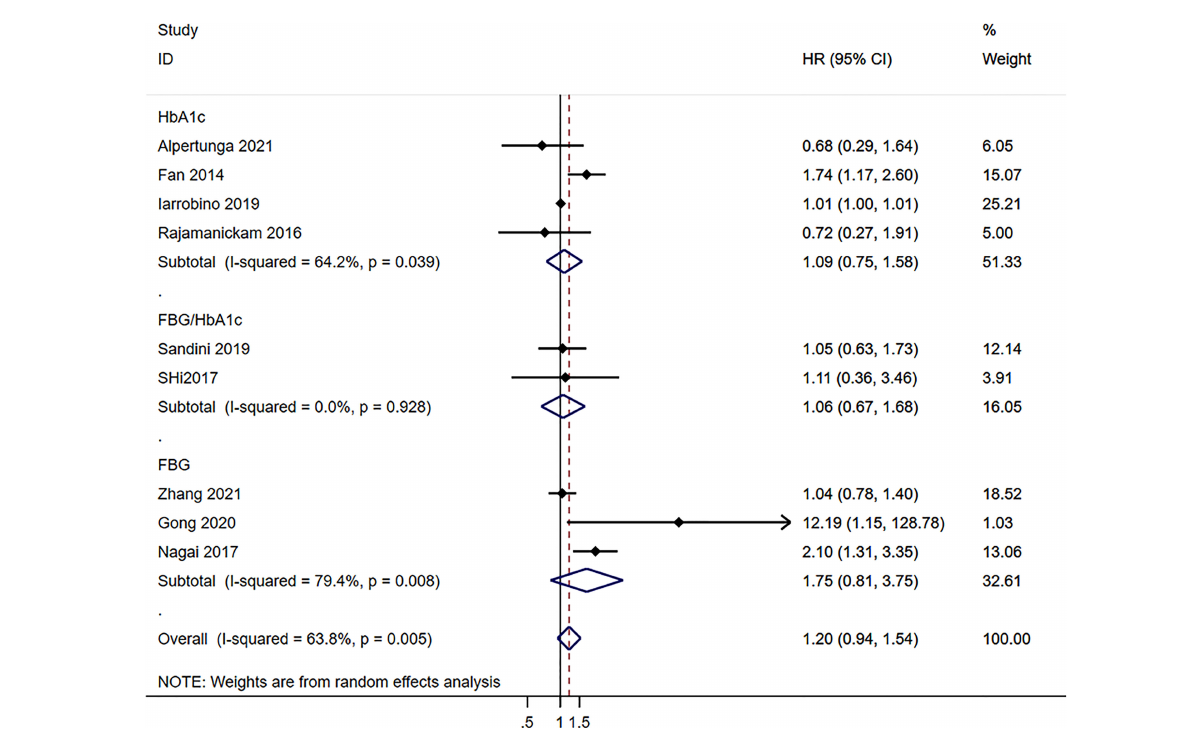
FIGURE 3 | Subgroup analysis of overall survival in the pancreatic cancer population according to the blood glucose levels according to the type of